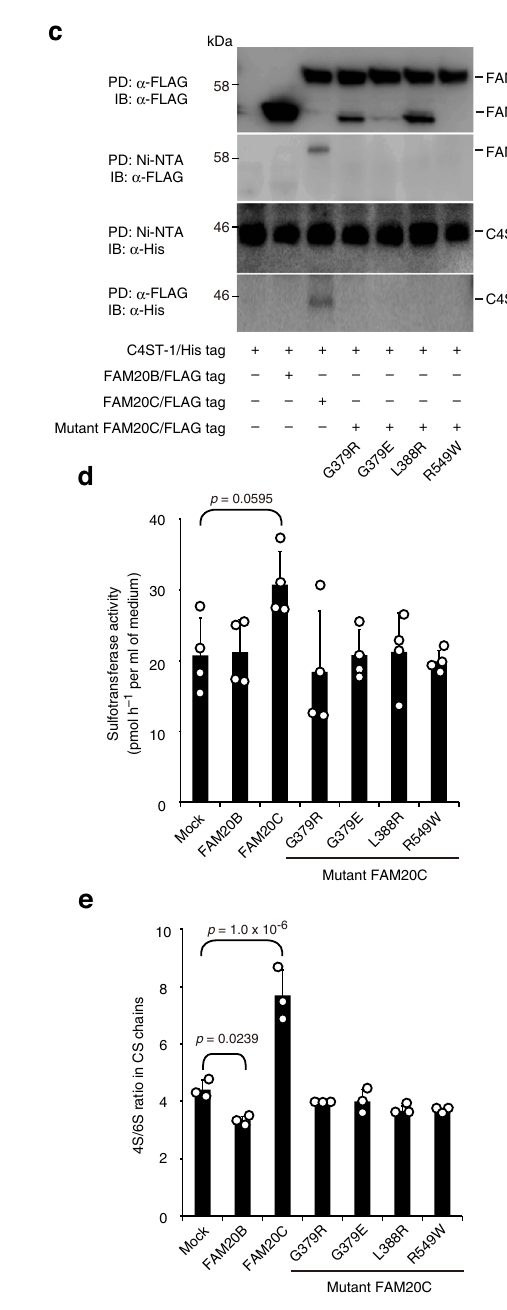
Fig. 2 | FAM20C-mediated control of CS biosynthesis is exerted by its physical interaction with C4ST-1. a Schematic diagram of sulfation pathways for the chondroitin backbone. Characteristic CS disaccharide units, including A, C, D, and E,aresequentiallyformedunderthecontrolofCS-speci fi csulfotransferasessuchas C4ST-1, C4ST-2, and C6ST-1. b Gel fi ltration elution pro fi les of CS chains from mouse fi broblastic L or sog9 cells overexpressing wild-type FAM20B or FAM20C (Dataarederivedfromthesingleexperiment).Numberedarrowheads(200k,65k, 37k,and18k)indicatetheelutionpositionof200-,65-,37-,and18-kDasaccharides derived from size-de fi ned commercial dextran, respectively. c Pulldown (PD) and immunoblotting (IB) analysis of culture medium from COS-1 cells co-expressing